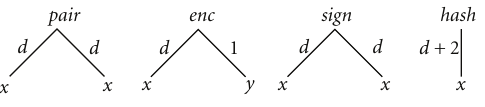
Figure 4: Safe costs